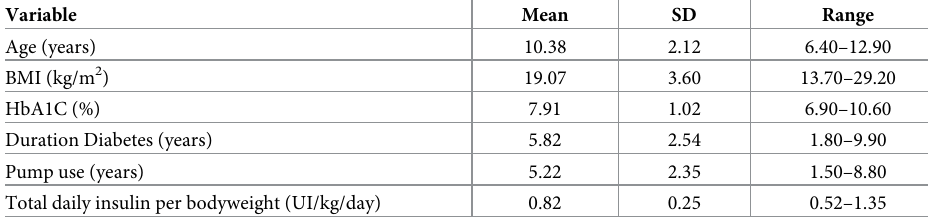
Table 1. Demographic characteristics of the participants (N = 14).